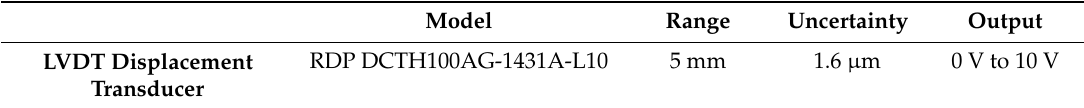
Figure 1. Schematic diagram of the UTM (left) and the sample located between the compression plates (right). Table 2. LVDT displacement transducer.